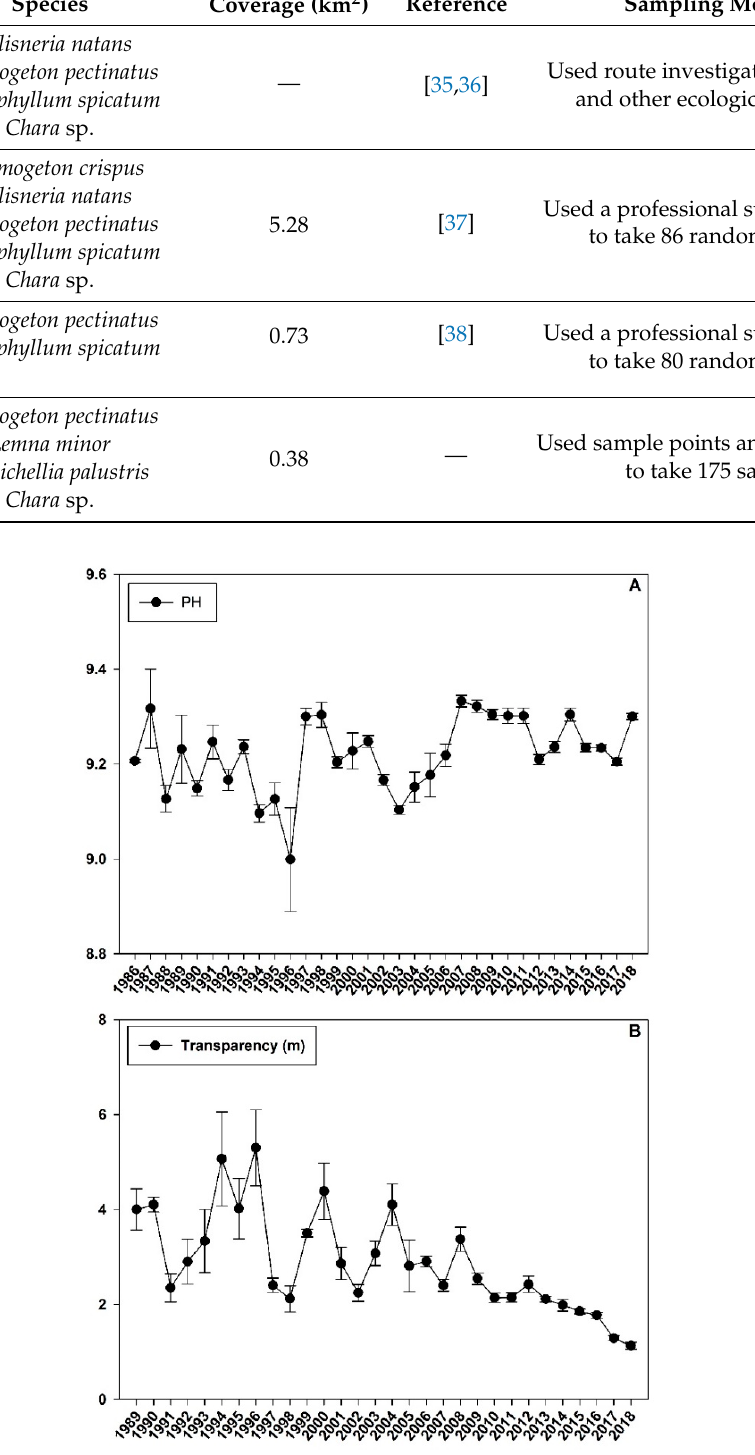
Figure 2. The historical water quality data ( A ): pH; ( B ): transparency in Chenghai Lake from 1986 to 2018.